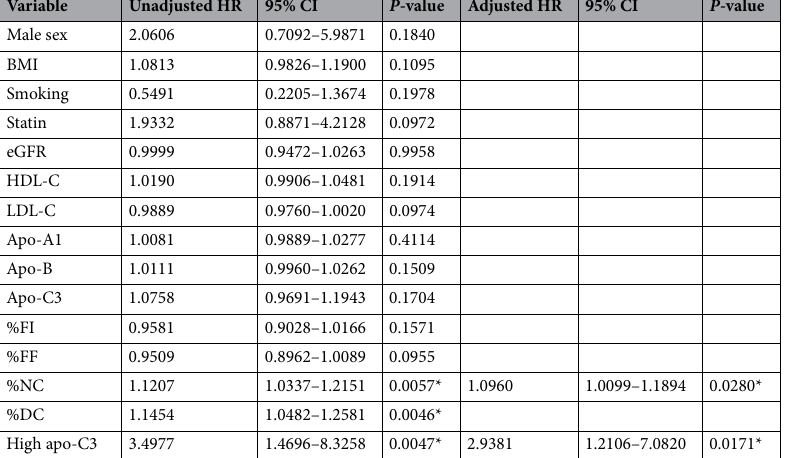
Table 4. Univariate and multivariate Cox hazards analyses for predicting 4 year MACEs. apo-C3 Apolipoprotein C3; MACE Major cardiovascular event; HR Hazard ratio; CI Confidence interval; BMI Body mass index; eGFR, Estimated glomerular filtration rate; HDL-C High-density lipoprotein cholesterol; LDL-C Low-density lipoprotein cholesterol; %FI Percentage of the FI volume in the plaque volume; %FF Percentage of the FF volume in the plaque volume; %NC Percentage of the NC volume in the plaque volume; %DC Percentage of the DC volume in the plaque volume; high apo-C3, patients with apo-C3 > 8.5 mg/dL. * P < 0.05.